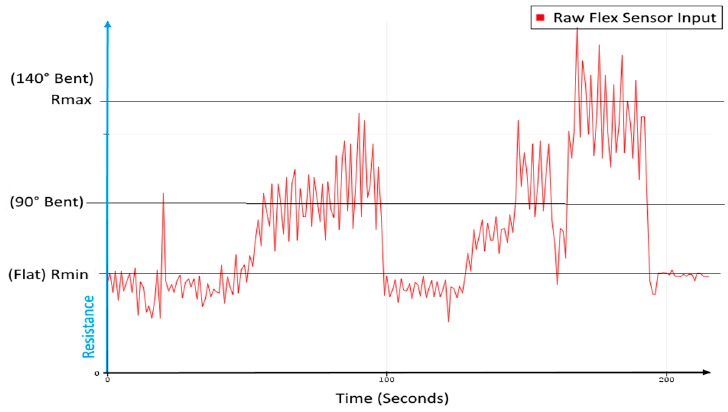
Figure 19. Raw input graph of flex sensor.